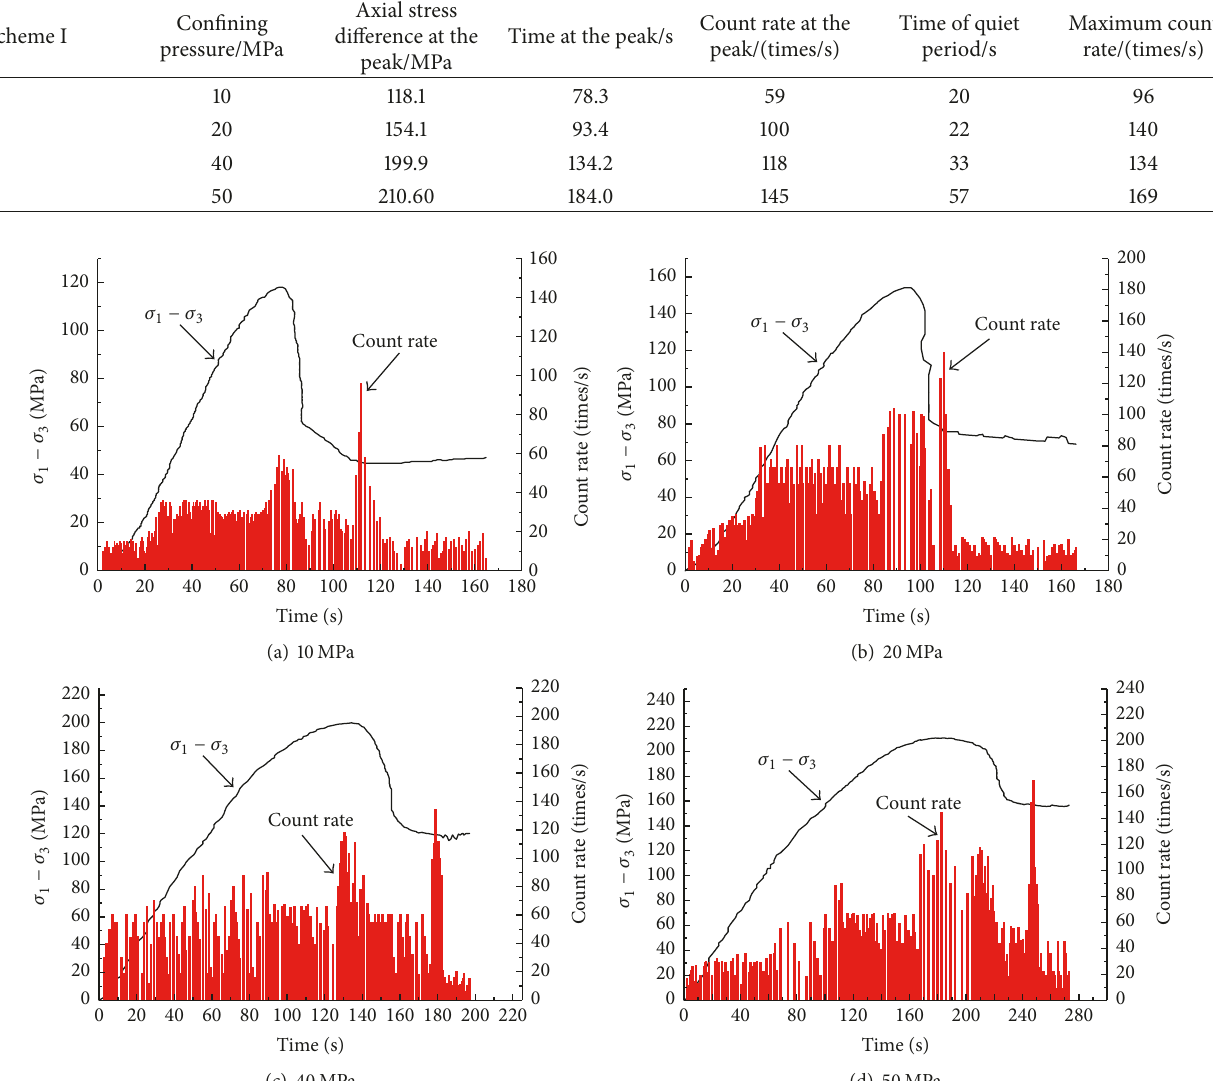
Table 1: Count rate of sandstone sample under various confining pressures in Scheme I.